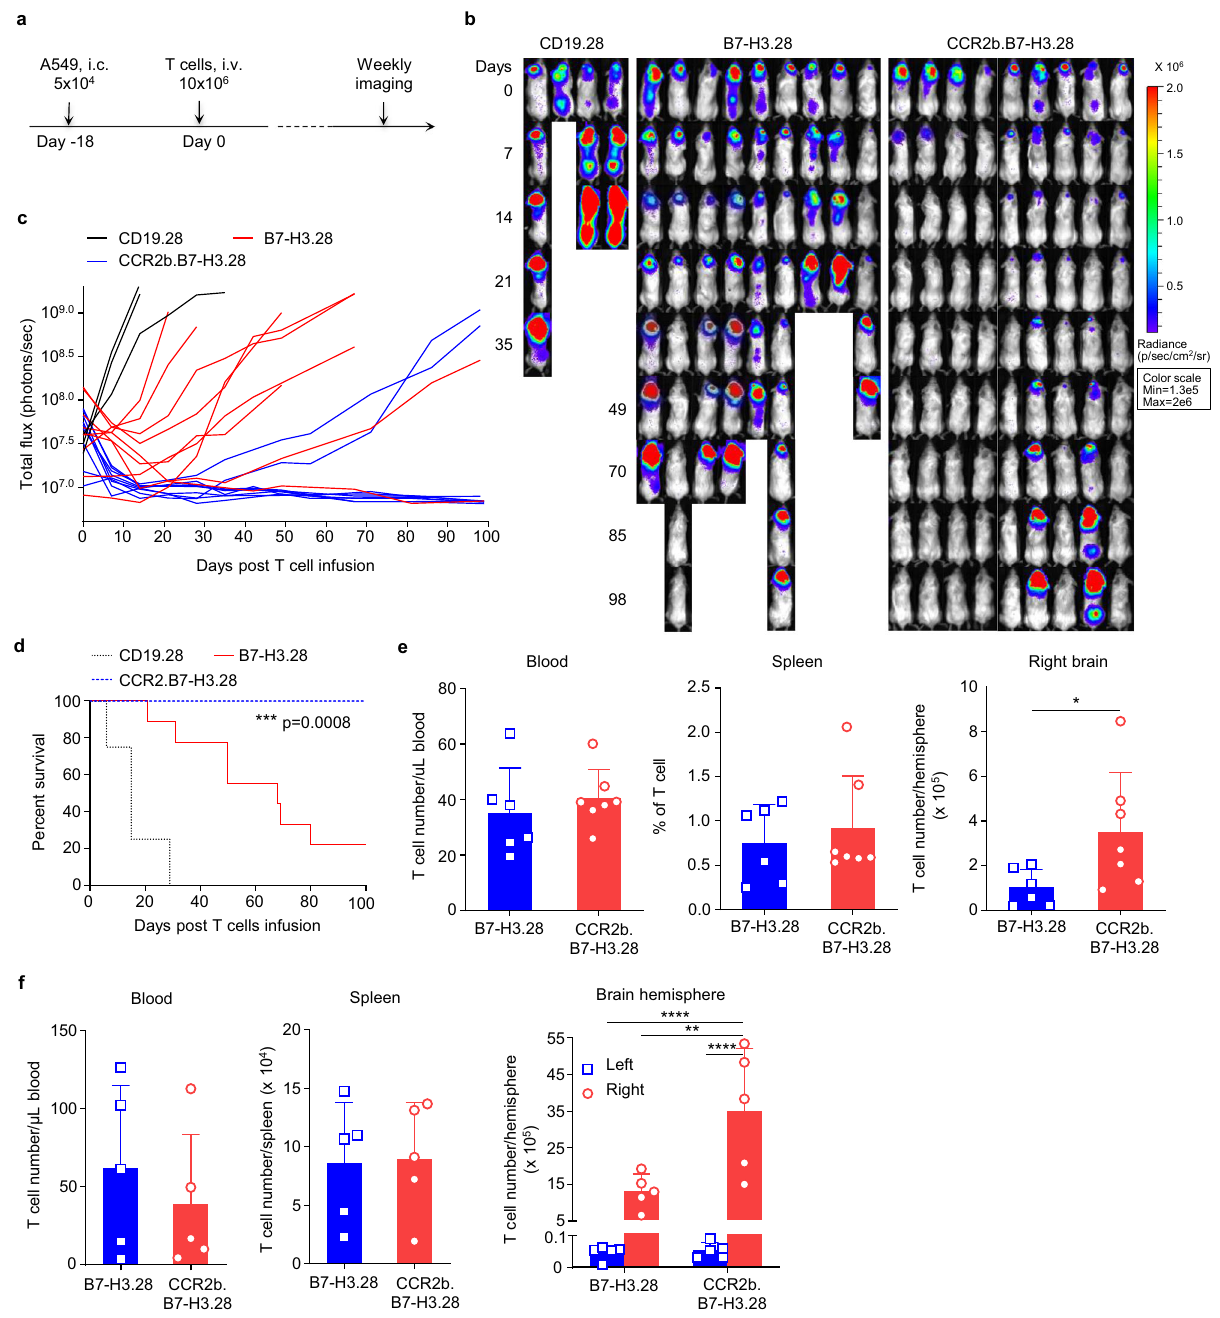
Fig. 5 B7-H3.CAR-T cells co-expressing CCR2b have superior antitumor activity against the A549 tumor in the brain. a Schematic of the A549 brain tumor model in which NSG mice were implanted intracranially (i.c.) with FFluc-A549 cells (5 × 10 4 cells) into the right brain hemisphere, and then treated with CD19.28, B7-H3.28, or CCR2b.B7-H3.28 CAR-T cells (10 × 10 6 ) inoculated i.v. 18 days later. b , c Representative tumor BLI images ( b ) and BLI kinetics ( c ) in the model shown in ( a ). Days indicated in ( b ) represent the days post T cell infusion. d Kaplan – Meier survival curves of mice in ( b ). *** p = 0.0008 (CCR2b.B7-H3.28 vs. B7-H3.28), χ 2 test. N = 4 mice in CD19.28 group, and n = 9 mice in B7-H3.28 and CCR2b.B7-H3.28 in ( c , d ). e In the